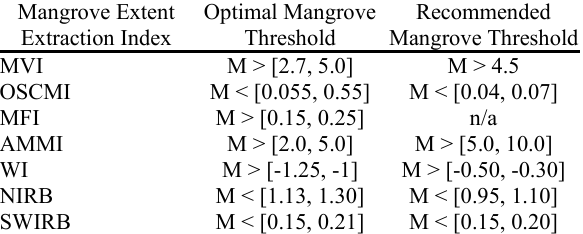
Table 3. The optimal mangrove threshold of each mangrove index vs the recommended threshold by the proponents.